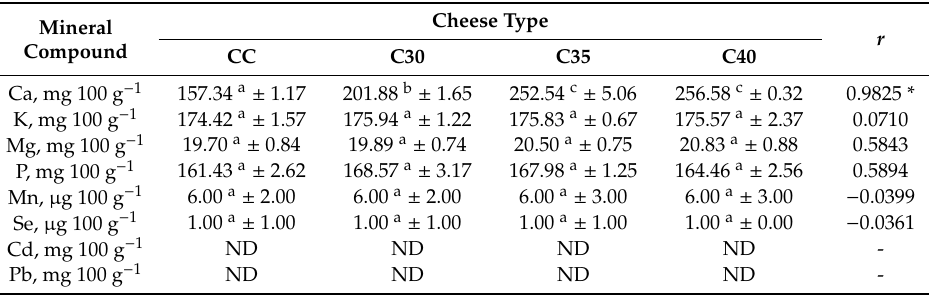
Table 3. Mineral composition of acid-curd